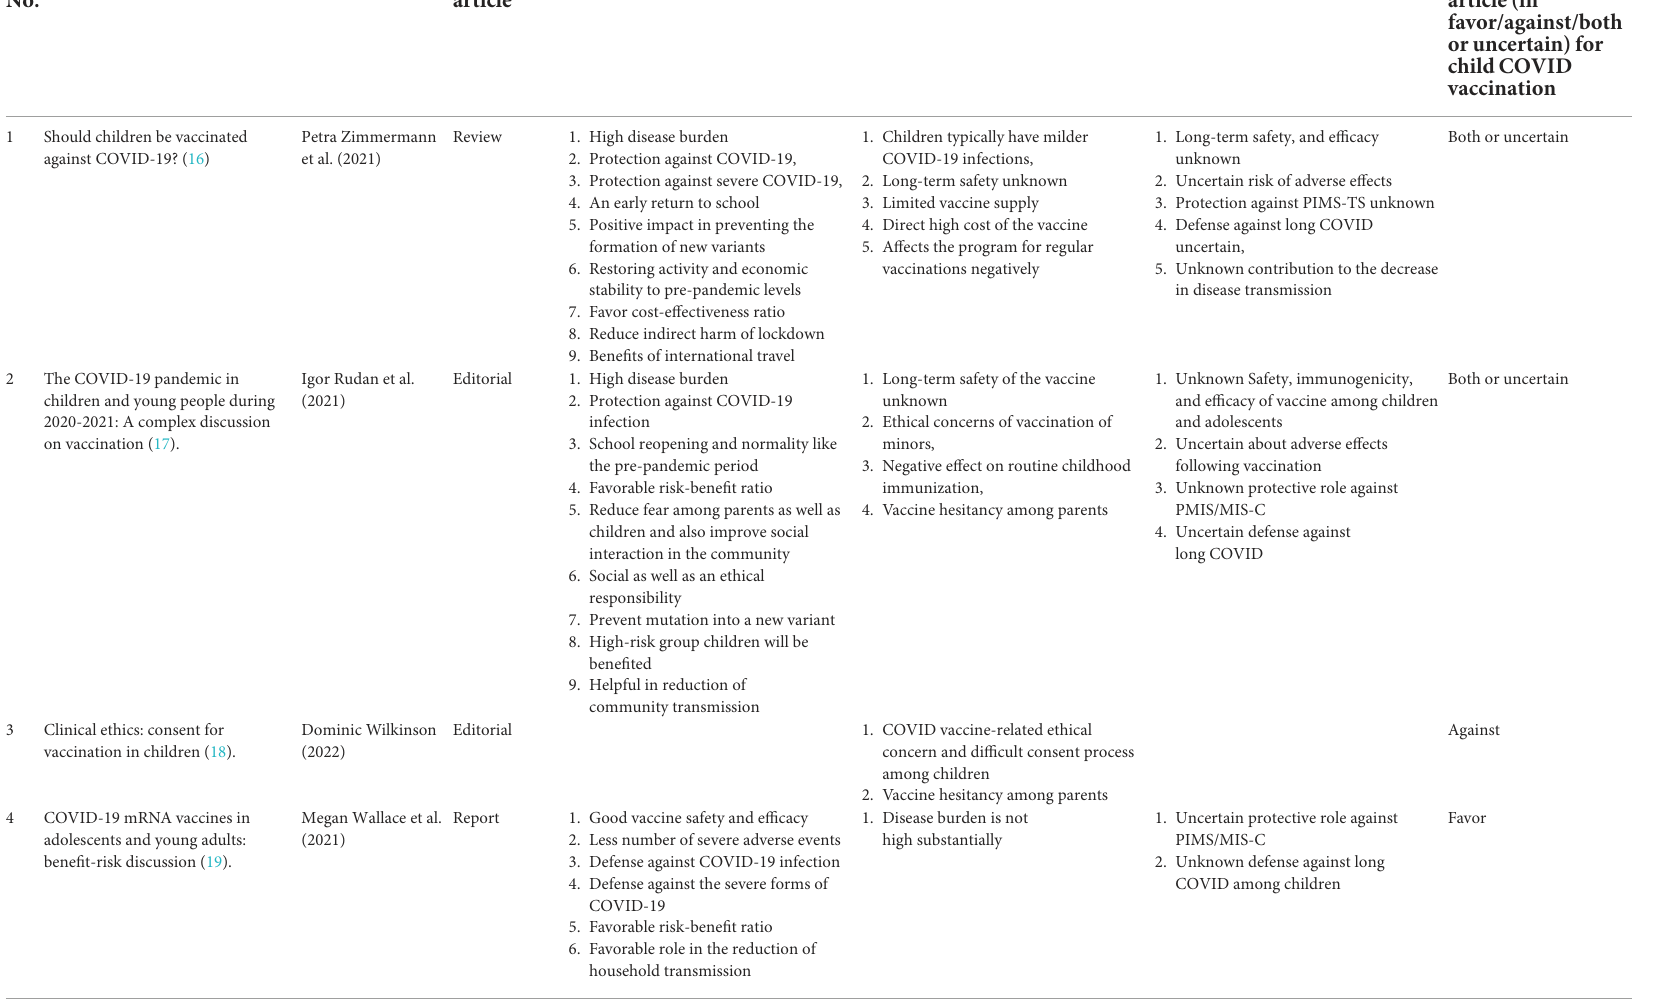
TABLE 3 Summary of the included study and description of factors discussed related to childhood COVID vaccination. Sr. No.